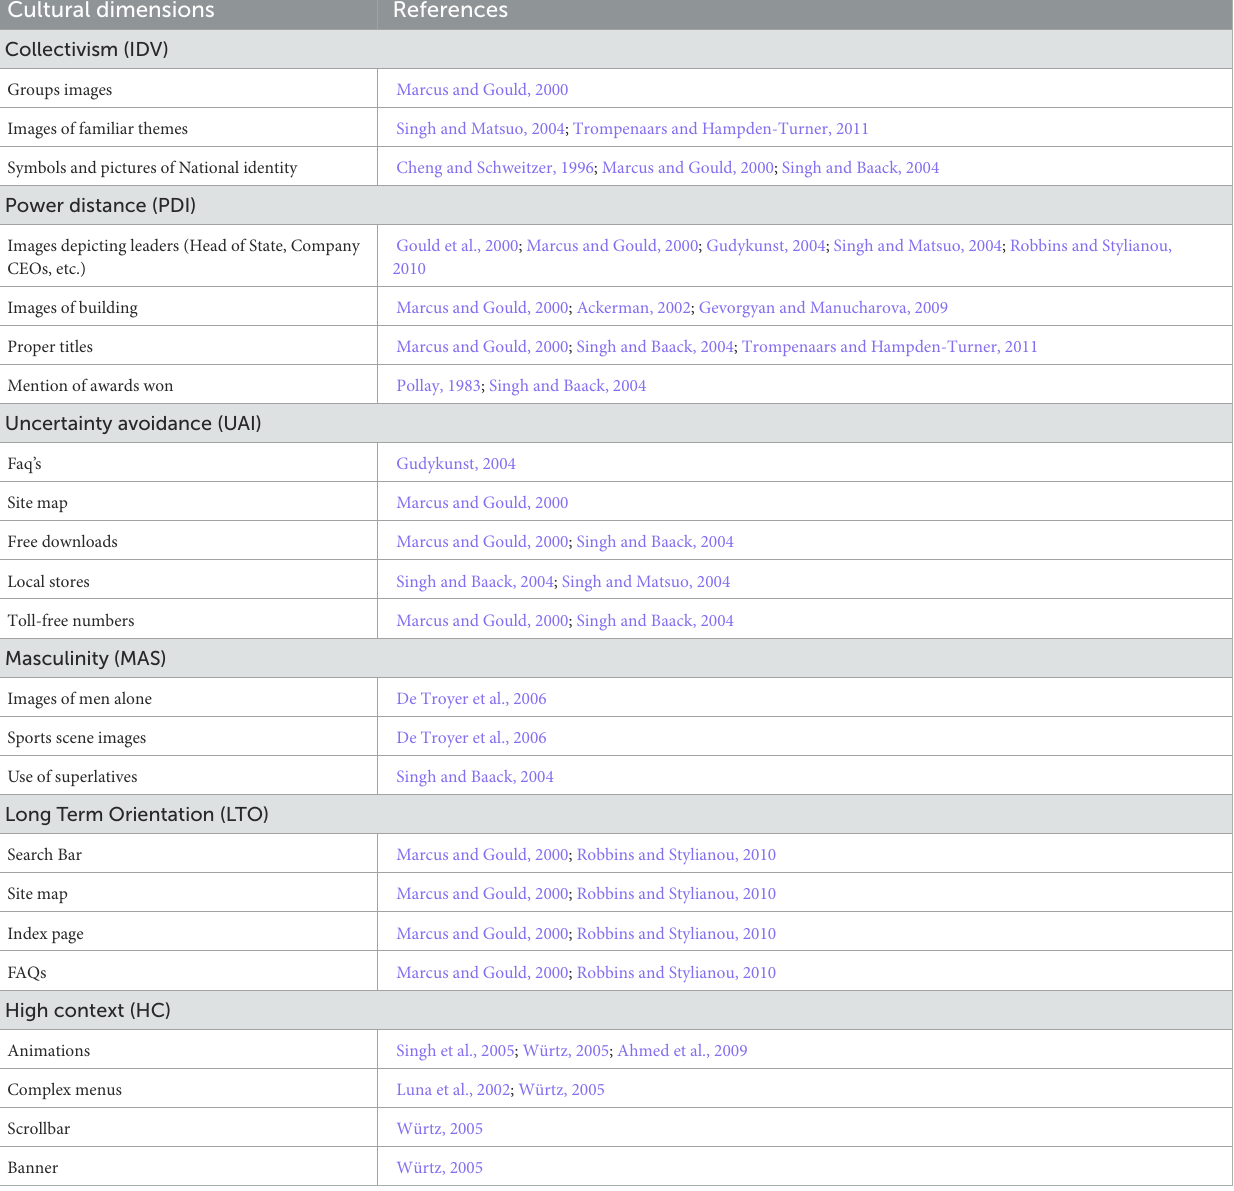
TABLE 1 Website characteristics related to Hofstede’s and Hall’s cultural